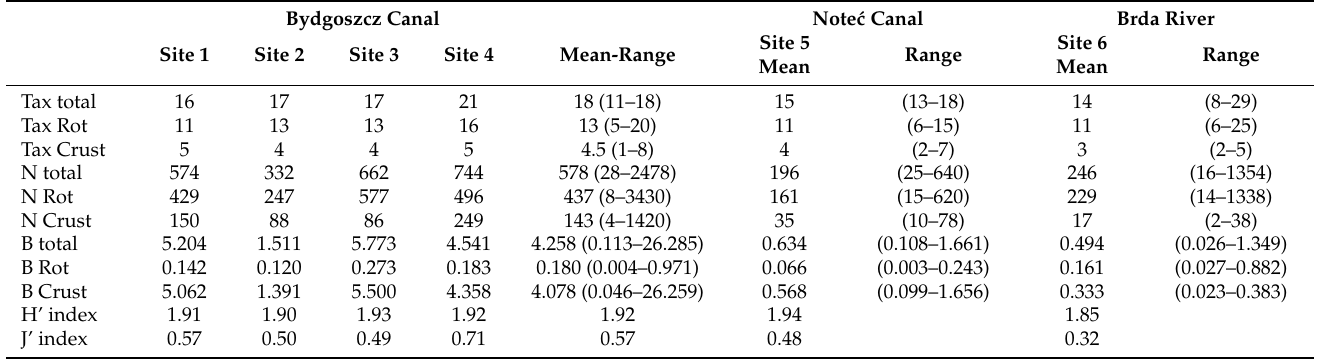
Table 3. Diversity (H’ index), evenness (J’ index), number of zooplankton species, zooplankton density, and biomass during vegetation season in the Bydgoszcz Canal, the Note´c Canal, and Brda River sites. Shannon–Weaver α -diversity index (H’ index), Pielou’s evenness index (J’ index), Tax